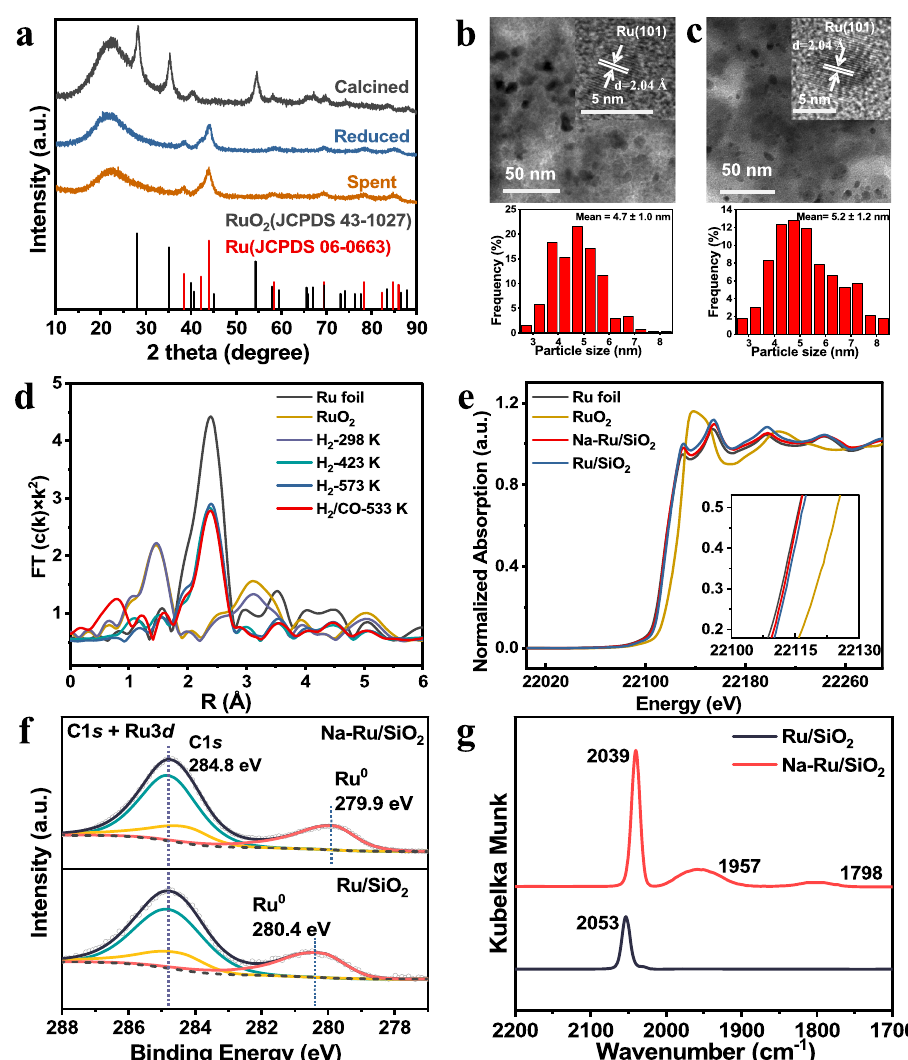
Fig. 2 | Characterization ofNa-Ru/SiO 2 and Ru/SiO 2 catalysts. a XRD patterns of Na-Ru/SiO 2 atdifferentstages. b , c (HR)TEMimagesandsizedistributionofRuNPs for Na-Ru/SiO 2 . b Reduced sample; c Spent sample. [Insets: Lattice fringes with distanceof2.04ÅcorrespondingtotheRu(101)crystalplaneshownin( b , c )]. d Ru